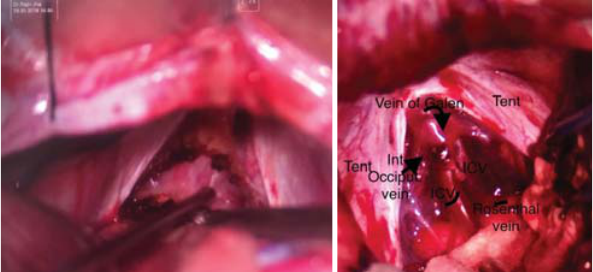
Figure 7. Intra operative picture showing pineal tumor and other structures.